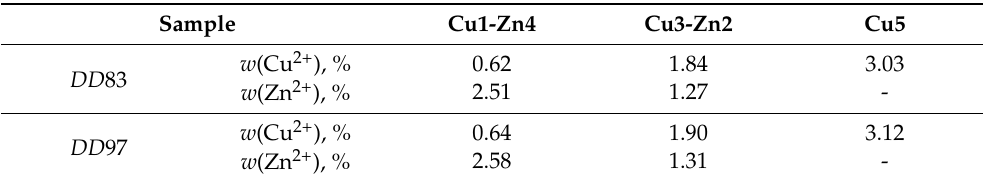
Table 1. The weight fractions ( w ) of Cu 2+ and Zn 2+ ions in bimetallic-chitosan-complex solutions. DD represents the deacetylation degree of chitosan.